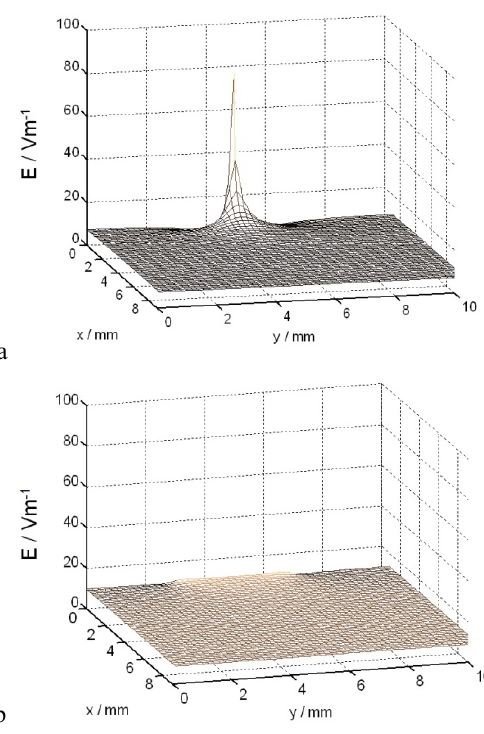
Fig.16: Electric field strength near the electrode: a) Ø electrode = 0.2 mm and b) Ø electrode = 4 mm in a cylindric chamber with a diameter of 10 mm with a voltage of 100 mV applied against a distant electrode at 10 mm. Only the plane in the middle of the chamber is shown.